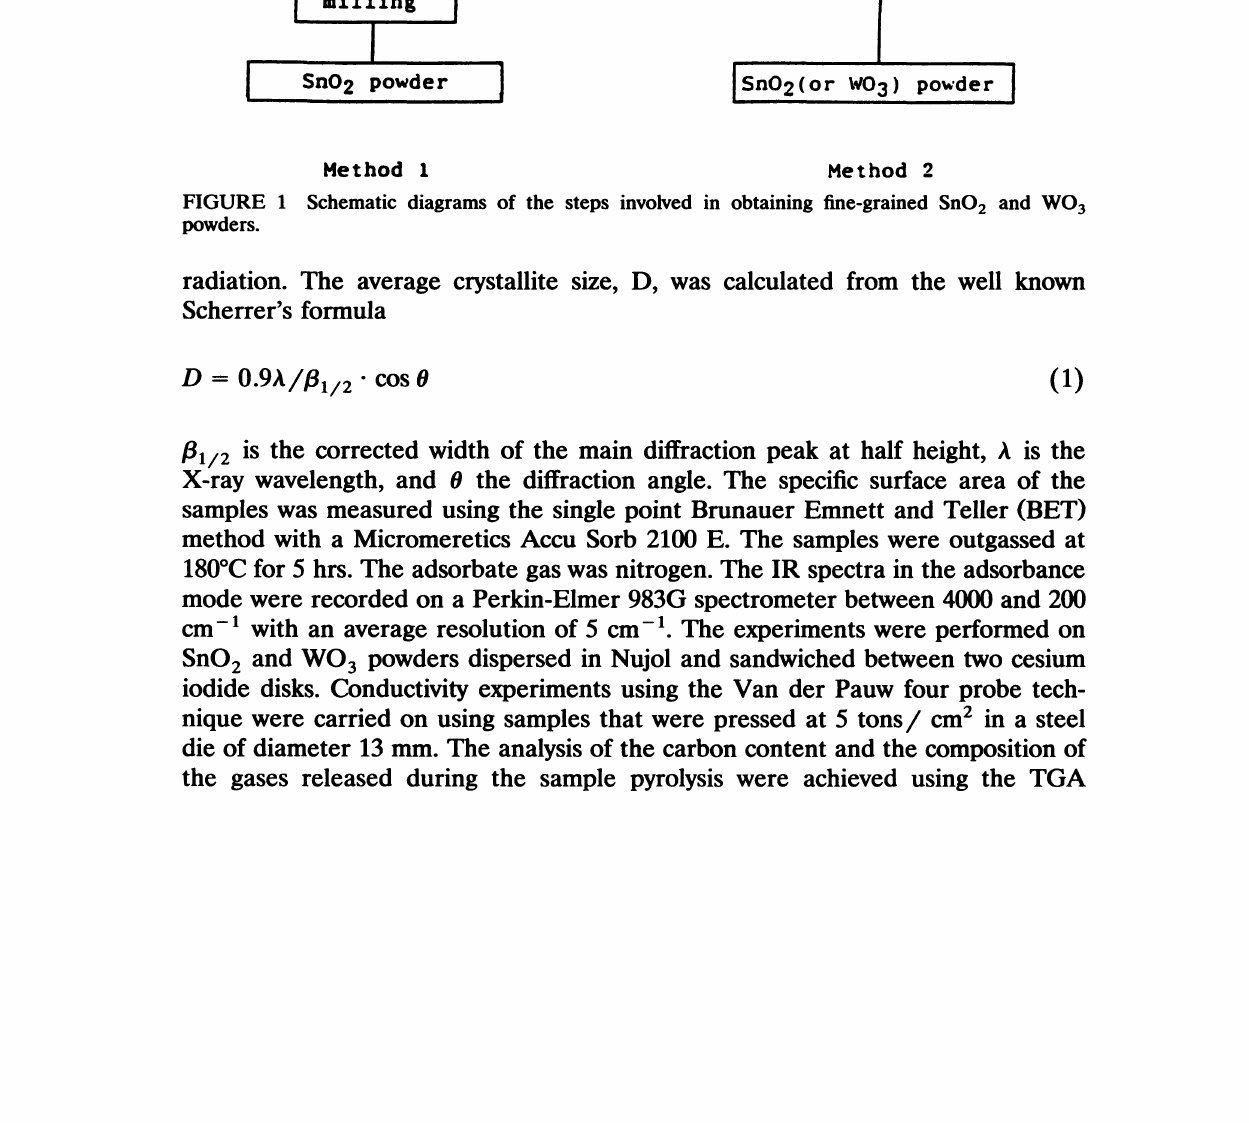
Plethod 1 Pie t hod 2 FIGURE 1 Schematic diagrams of the steps involved in obtaining fine-grained SnO 2 and WO 3 powders. radiation. The average crystallite size, D, was calculated from the well